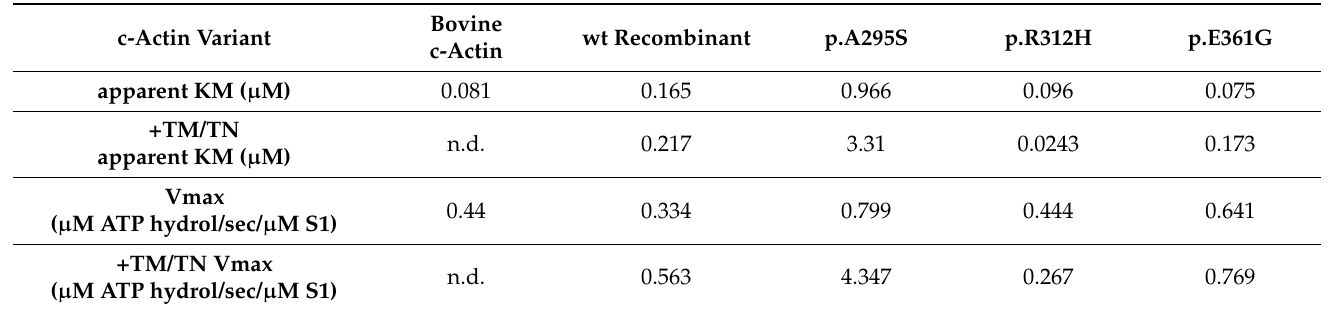
Table 2. Kinetic parameters of the myosin-S1 ATPase stimulation by the c-actins. Apparent K M and Vmax values of the myosin-S1 ATPase stimulation by the c-actin variants (n.d. = not determined).